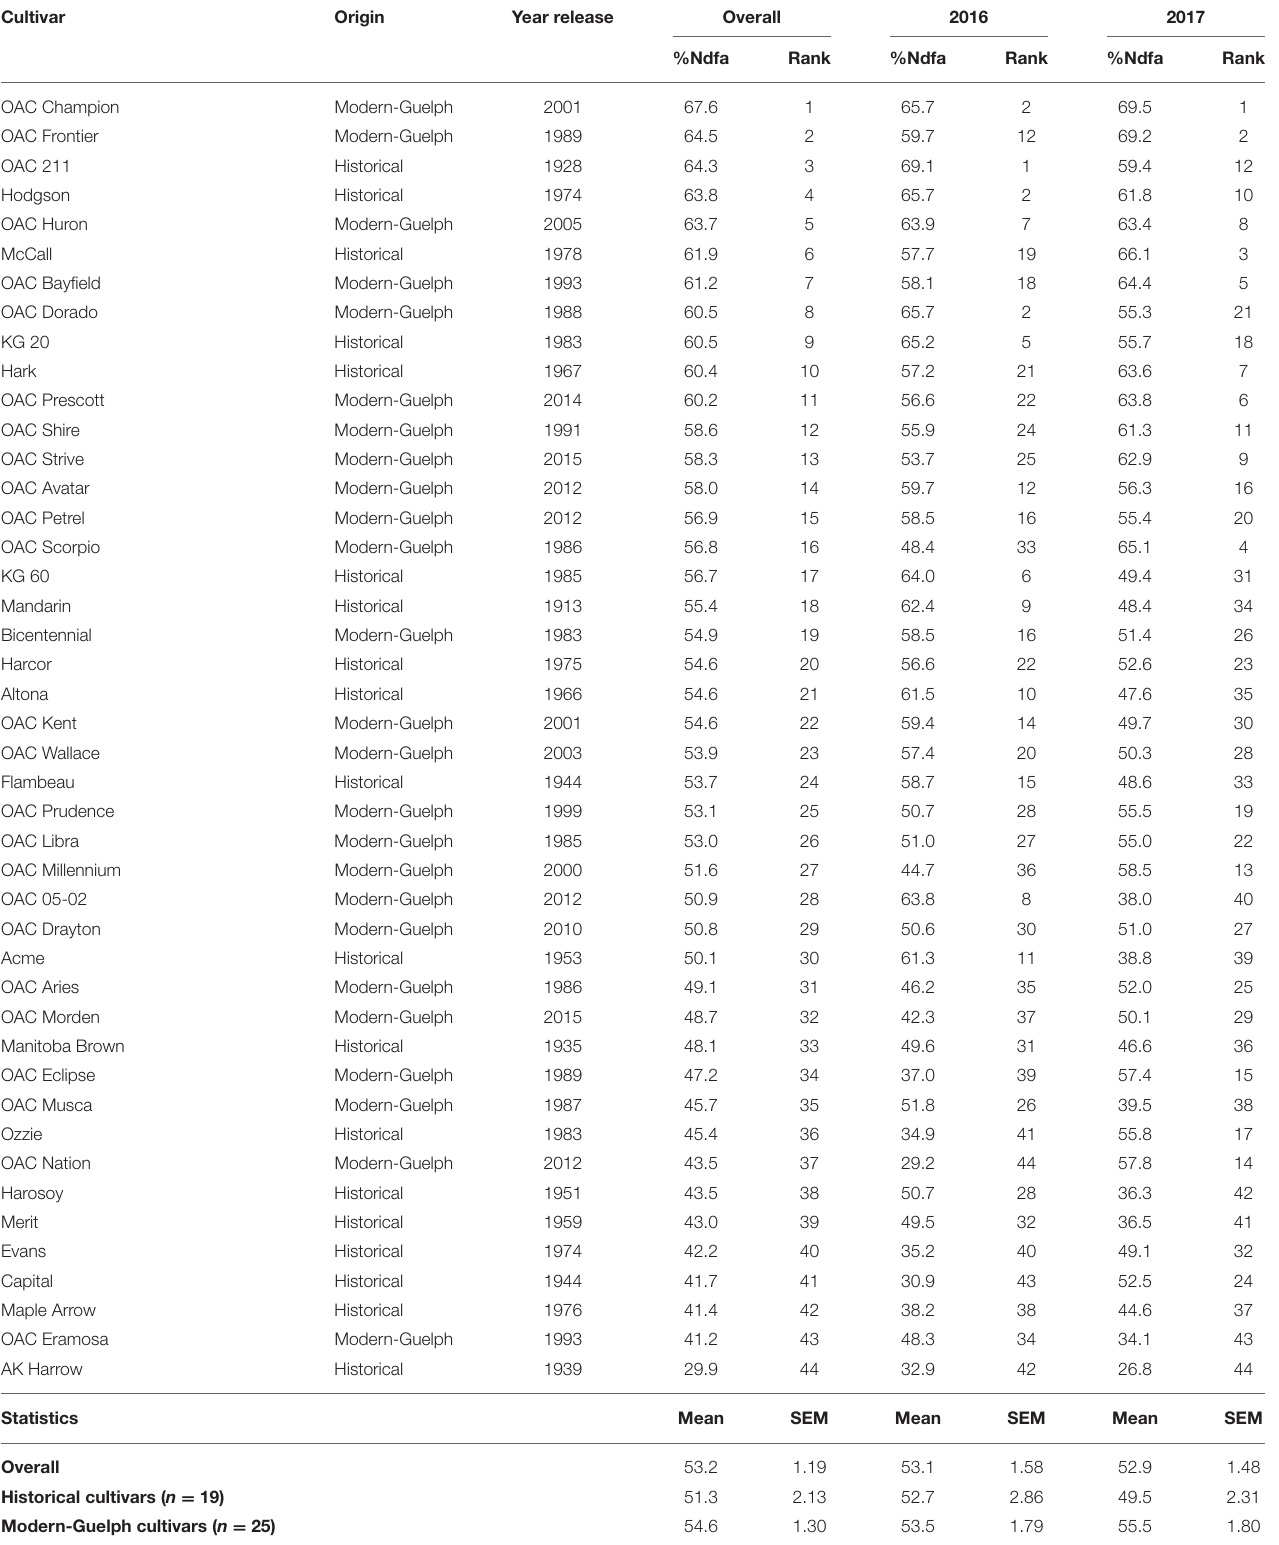
TABLE 1 | Ranking of soybean cultivars based on accumulated nitrogen derived from the atmosphere (%Ndfa) in shoots prior to the pod-filling stage in the 2016 and 2017 seasons.